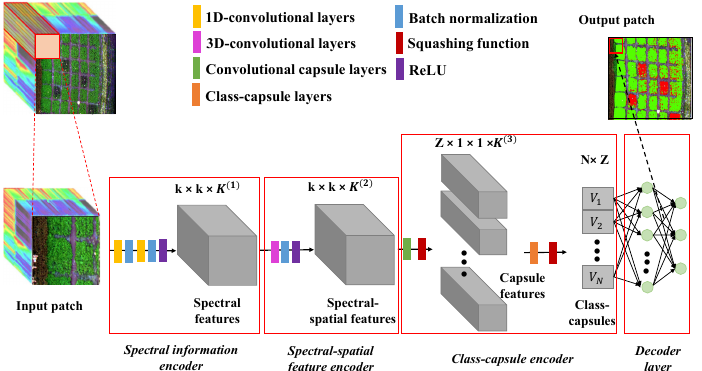
Figure 2. The workflow of the CropdepcNet framework for potato late blight disease diagnosis ( k is the spatial size of the convolutional kernel, K is the number of the channel of the convolutional kernel, Z is the dimensionality of the class-capsule, N is the number of the class-capsule, and V represents a vector of the high-level